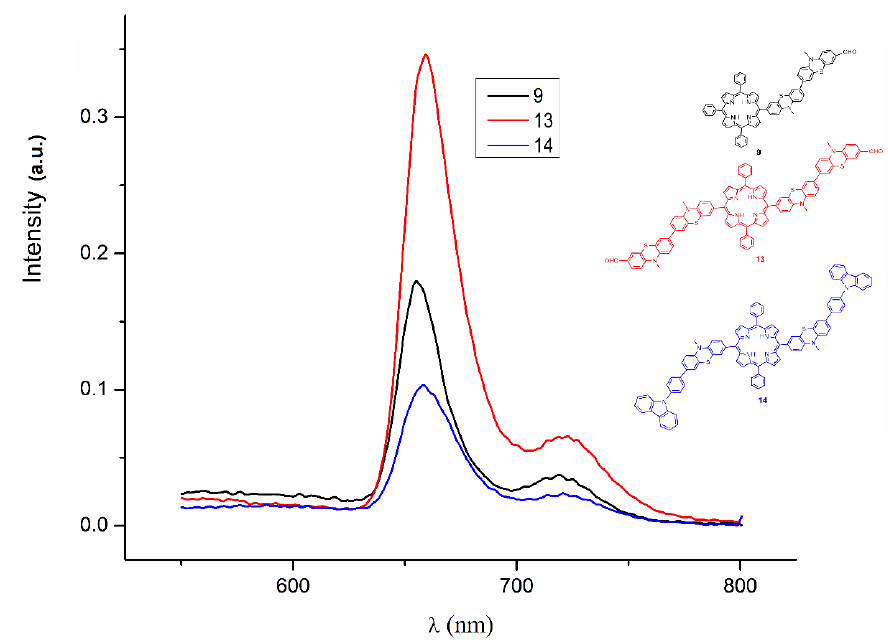
Figure 2. Emission spectra of phenothiazine-bridged porphyrin dyads containing phenothiazine 9 and 13 and carbazole 14 moieties after excitation at 420 nm.